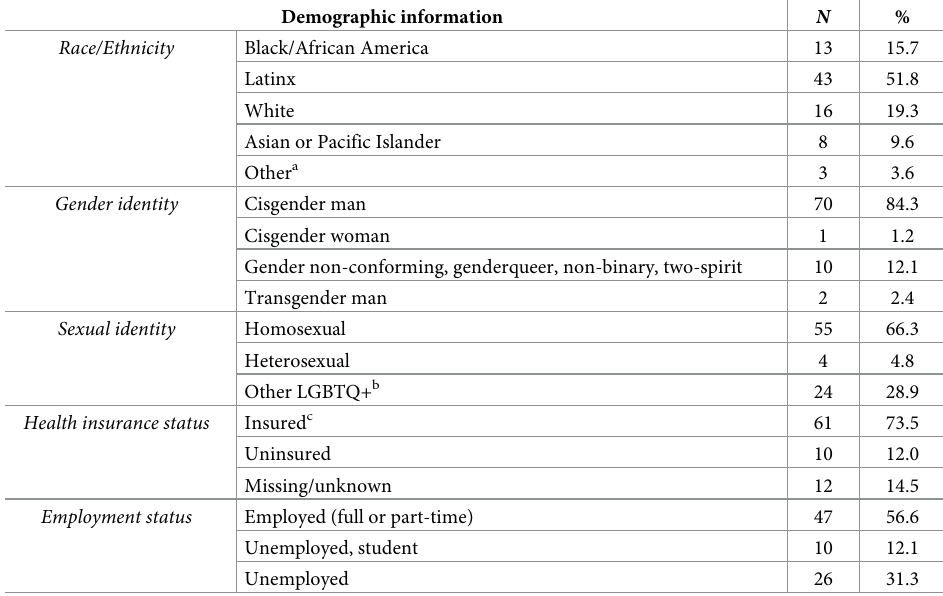
Table 1. Demographic and behavioral characteristics of participants (N =